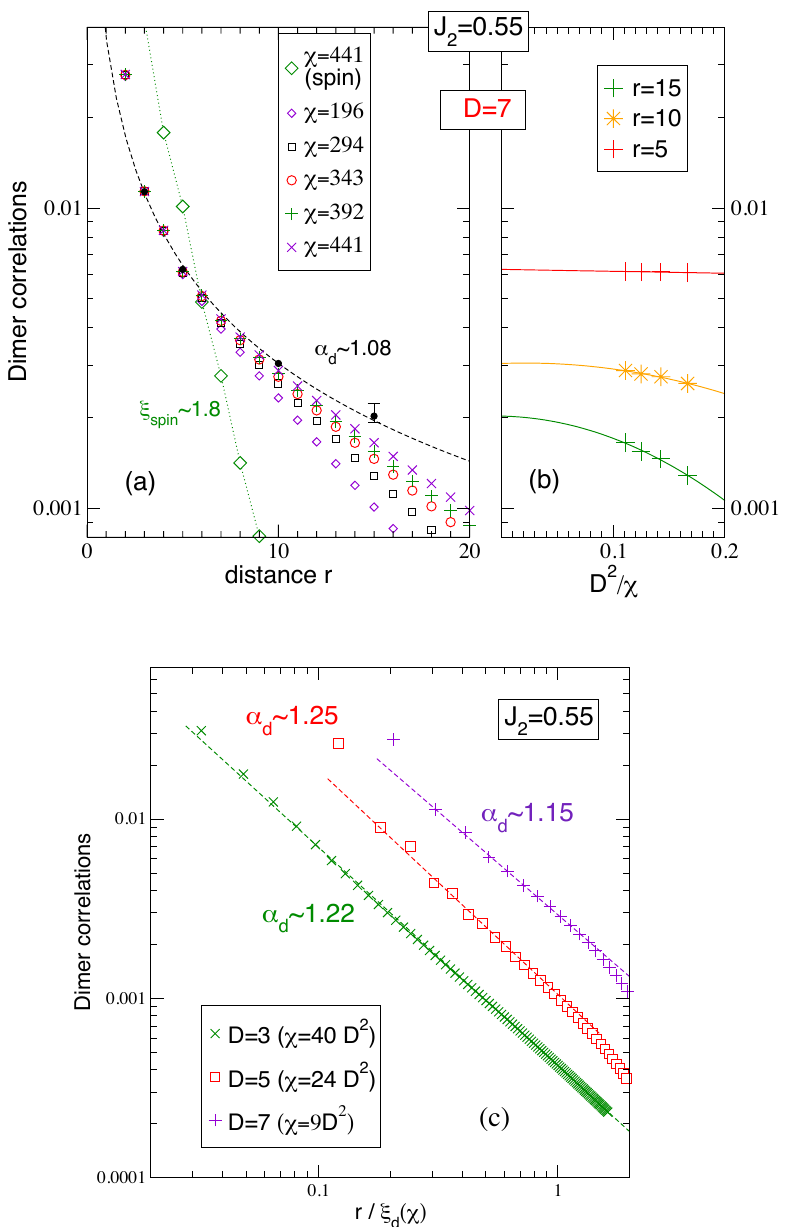
= 0.55, 2 ( χ ) . For the d (cid:39) 61.5,16.4 d